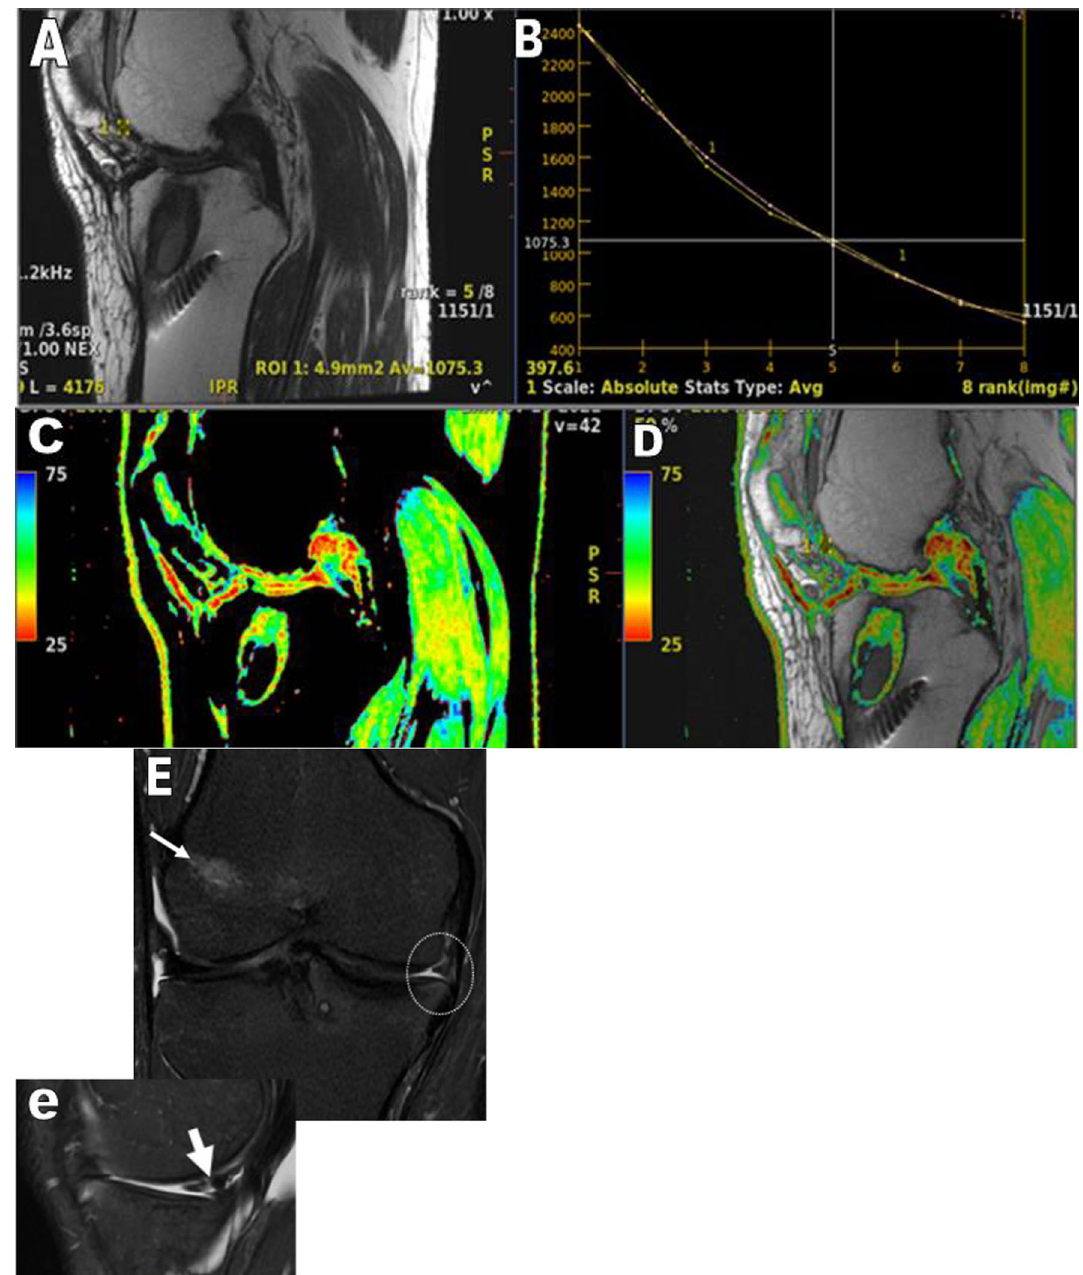
Fig. 6 A 40-year-old male patient underwent ACL reconstruction and medial meniscectomy 4.5 years ago, the patient complained of knee pain and swelling. In assessment of the MRI knee, the conventional images shows evidence of medial meniscectomy and mild knee joint effusion with taut signal of the ACL graft. Sagittal T2 image A along the medial femoral condyle anterior segment shows partial thinning of the articular cartilage. On the post processing T2 mapping image: ( C , D ) the colour image along the articular cartilage of the medial femoral condyle anterior segment revealed internal areas of blue colour (yellow ROI) with increased T2 value (as demonstrated within the curve image ( B )) that corresponds to articular cartilage degeneration. According to the international cartilage Repair Society (ICRS) grading system, this corresponds to grade II cartilage degeneration. Coronal ( E ) and focused sagittal STIR image upon the medial meniscus level (e), attenuated body and posterior horn of medial meniscus show intrasubstance heterogeneous band of increased signals reaching the articular surfaces, denoting meniscal re-tear (Thick white arrow/white dashed circle). Note the patchy bone marrow edema signal STIR signal (White